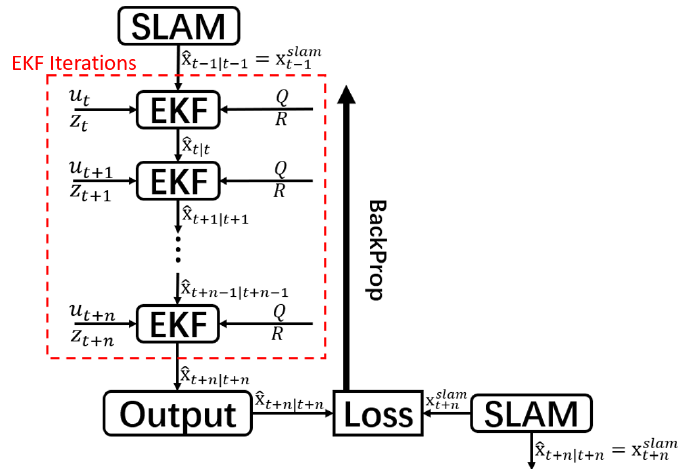
Figure 3. Structure and training flow of our network. The initial state of the EKF iterations is based on the previous SLAM state update at timestamp t − 1. N number of EKF iterations will be performed until the next update of the SLAM state at t + n . The loss is calculated between the SLAM state update and the final predicted output state of the N EKF updates. Then, backpropagation is performed on the basis of the calculated